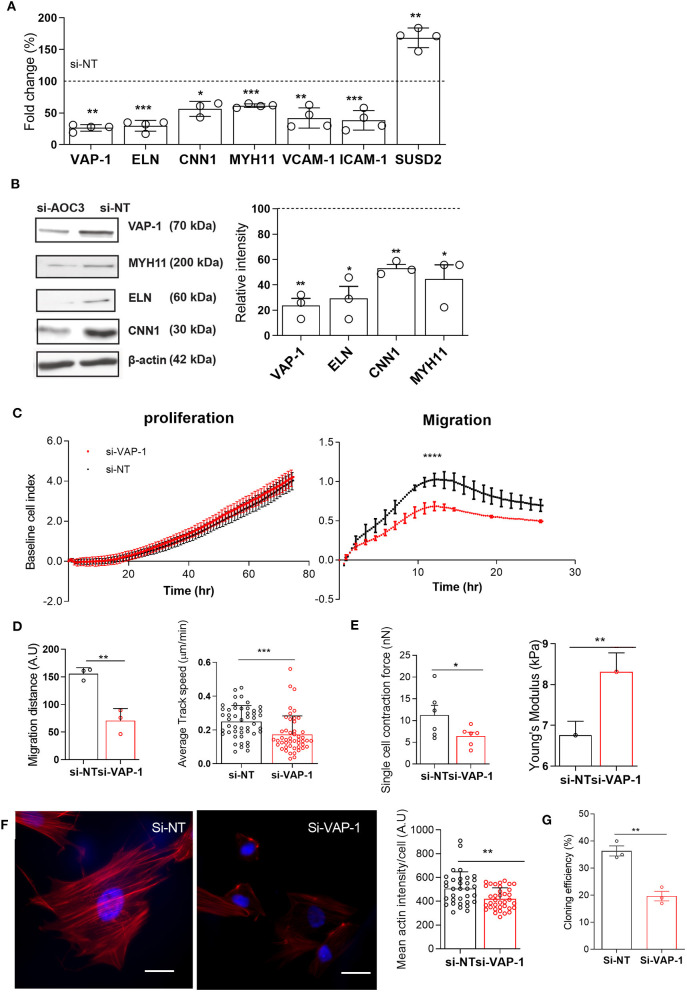
VAP-1 is a pivotal regulator of endometrial pericytes. (A) AOC3, ELN, CNN1, MYH11, VCAM1, ICAM1, and SUSD2 mRNA levels were determined in primary pericytes 48 h following transfection with either non-targeting siRNA (si-NT) or siRNA targeting AOC3 (si-VAP-1). (B) In parallel experiments, VAP-1, elastin (ELN), calponin 1 (CNN1), and myosin heavy chain 11 (MYH11) protein levels were determined by Western blot analysis, normalized to β-actin levels, and relative intensity determined by densitometry. The data show fold-change (mean ± SEM) in transcript and percent-change (mean ± SEM) in protein level, respectively in cultures first transfected with si-AOC3 compared to si-NT (dotted line). The experiments were repeated in three or more independent primary cultures (right panel). (C) Representative graphs showing the proliferative (left panel) and migratory capacity (right panel), monitored in real-time using the xCELLigence system, of primary pericytes 48 h following transfection with either si-NT or si-AOC3. (D) siRNA transfected pericytes were subjected to a scratch assay and monitored using live-cell microscopy (see Supplementary Video 1). Average migration (left panel) and track speed (right panel) was measured by tracking >10 cells in three independent primary culture. Data are mean ± SEM. Student's t-test; **P < 0.01; ***P < 0.001. (E) Pericytes first transfected with si-NT or si-AOC3 were embedded into collagen at a density of 1 × 106 cells per gel. Single cell contraction force per gel was measured using the depth-sensing nanoindentation system for force in 6 independent primary cultures. Data are mean ± SEM. Student's t-test; *P < 0.05. (Figure 2E, left panel). Cell stiffness, expressed as Young's modulus, was measured by atomic force microscopy in pericytes first transfected with either si-NT or si-AOC3 from three independent primary cultures. Mann–Whitney U-test. *P < 0.05 (Figure 2E, right panel). (F) Actin microfilaments (red) in primary pericytes first transfected with si-NT or si-AOC3 (left panel). Scale bar: 200 μm. The mean actin intensity per cells was measured in three biological repeat experiments using the image J software (right panel). Data are mean ± SEM. Mann–Whitney U test; **P < 0.01. (G) Cloning efficiency in pericytes transfected with si-NT and si-AOC3. Colony numbers were counted on day 12. Data are pooled from 3 independent experiments and displayed as mean ± sem. Student's t-test; **P < 0.01; ****P < 0.0001.